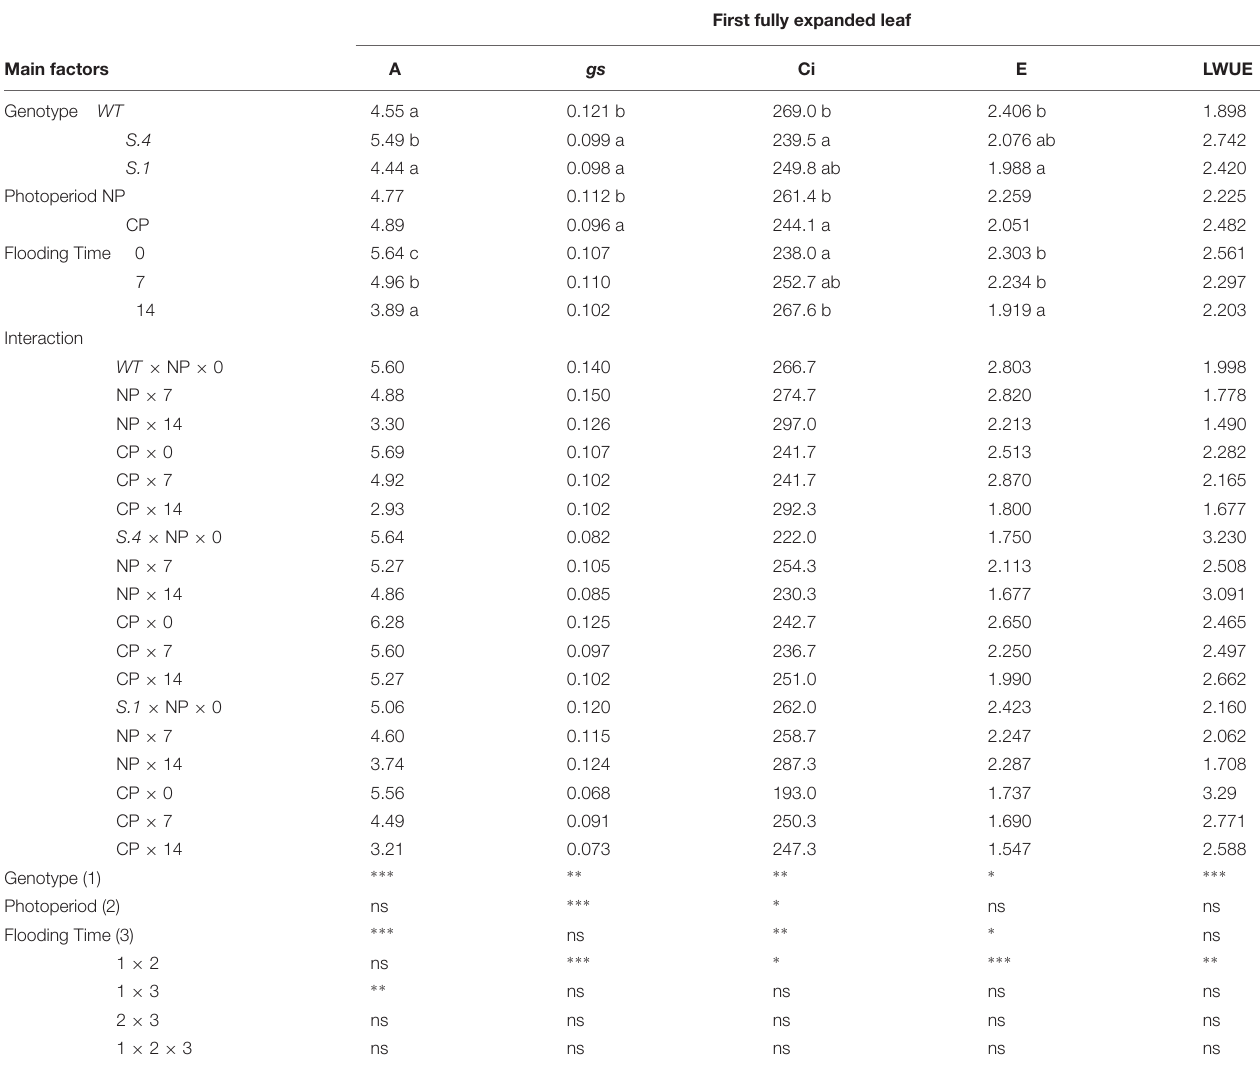
TABLE 2 | Gas exchange parameters measured at 0, 7th, and 14th days from the beginning of flooding stress for plant of the three genotypes grown under NP and CP, detected during the 2016 test.